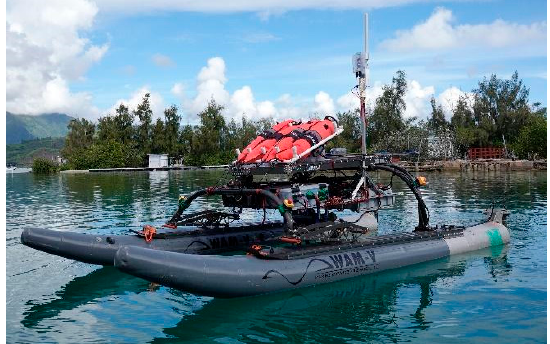
Figure 5. WAM-V equipped with Starfish 990F at the MTR.